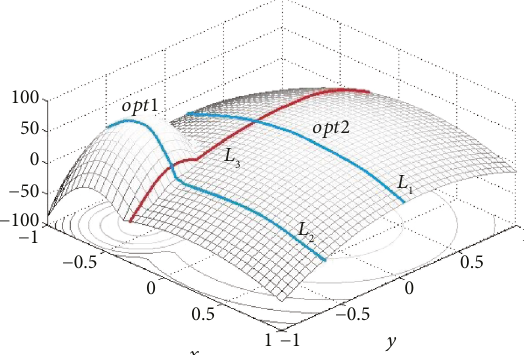
Figure 2: Landscape of the MTQ function with H